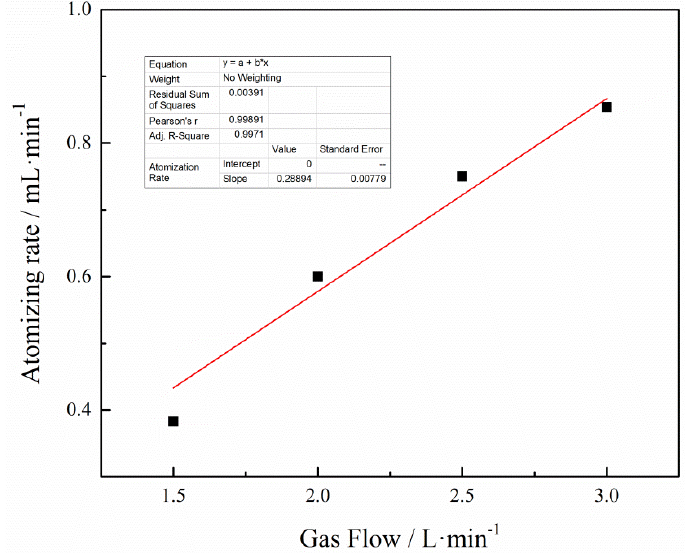
Figure 3. The change of atomizing rate of the NaClO 2 solution with gas flow.